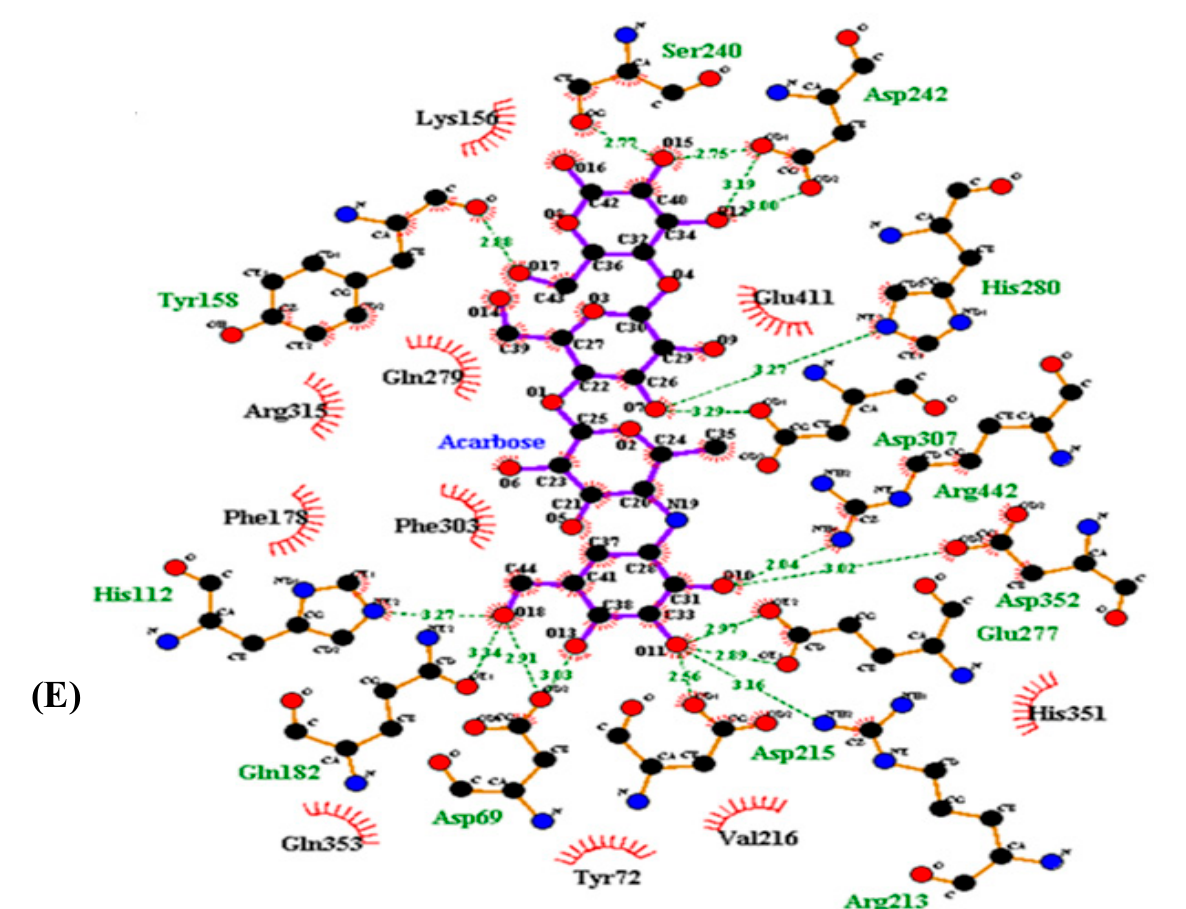
Figure 3. Two-dimensional ligand interaction diagram of α -glucosidase inhibition by (+)-trans-decursidinol ( A ), Pd-C-I ( B ), Pd-C-II ( C ), Pd-C-III ( D ), and acarbose ( E ). Schematic display of the interaction of ligands (coumarins) and α -glucosidase, coumarins present thick purple stick models, hydrogen bonds are green dotted and hydrophobic interactions of dashed half-moons with the enzyme’s respective amino acid